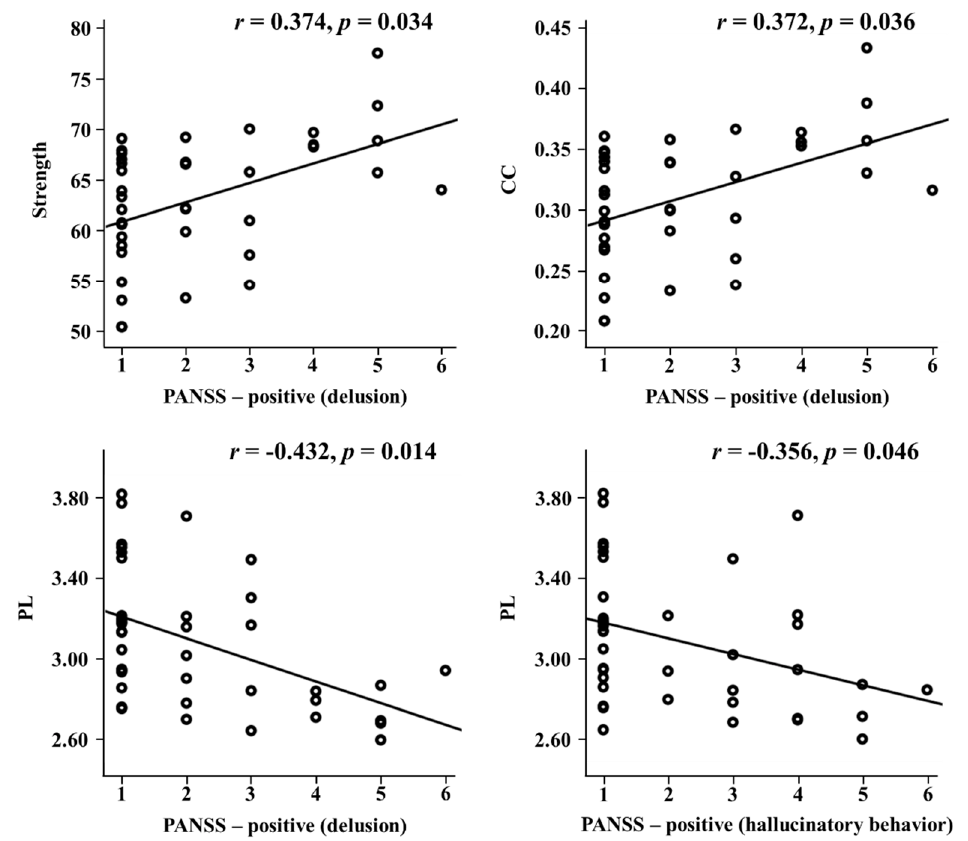
Figure 1. Correlations of global network indices with PANSS positive subscales in schizophrenia. PANSS: positive and negative syndrome scale; CC: clustering coefficient; PL: path length.